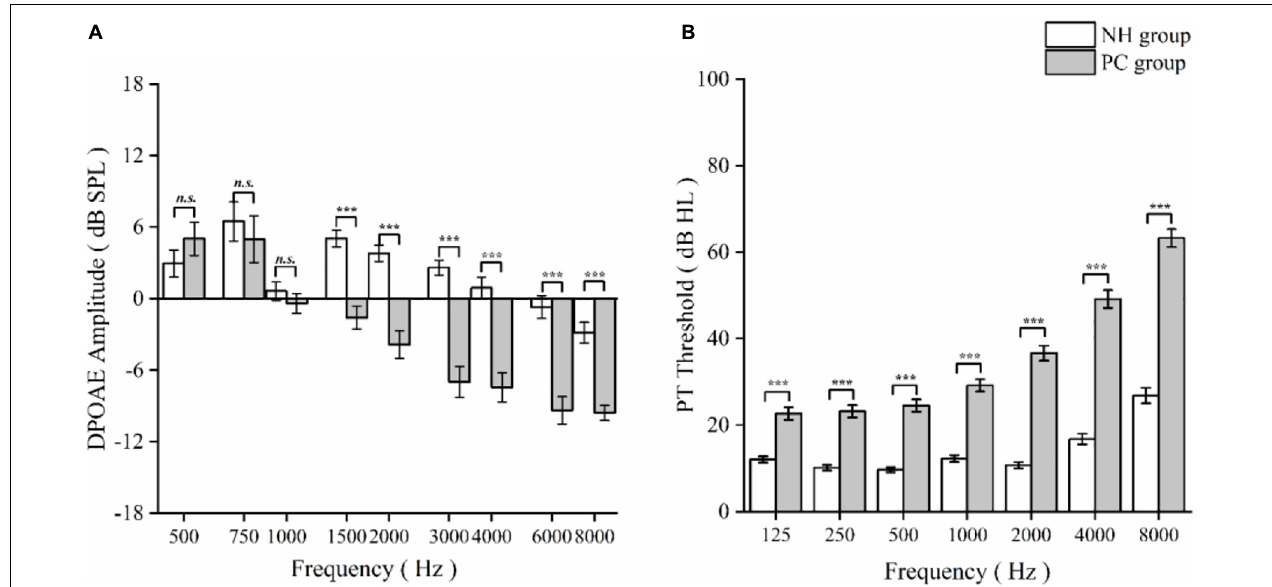
FIGURE 1 | Comparison of distortion product otoacoustic emission (DPOAE) detection amplitudes and pure threshold (PT) thresholds between normal hearing (NH) and presbycusis (PC) groups as a function of frequency. (A) DPOAE detection amplitudes at different frequencies in NH and PC group. (B) PT thresholds at different frequencies in NH and PC groups. The data are presented as means ± standard error. Asterisk values indicate a statistically significant difference with a p -value < 0.05. n. s., non-significant; *** p <